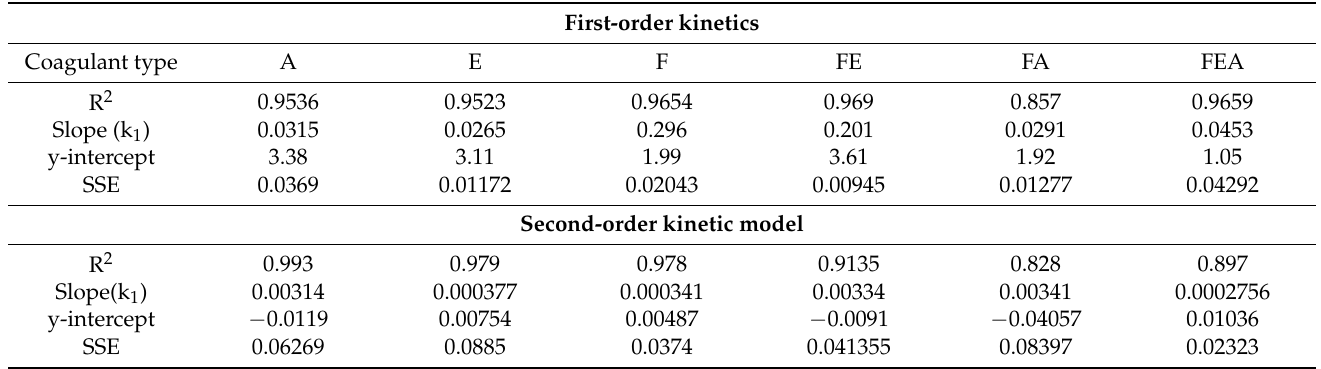
Figure 7. Kinetics of ( a ) second-order and ( b ) first-order models for the removal of turbidity. Table 4. Comparative kinetics